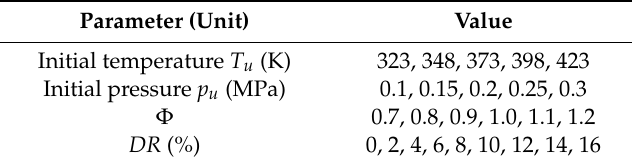
Table 2. Test conditions of natural gas-CO 2 mixture.